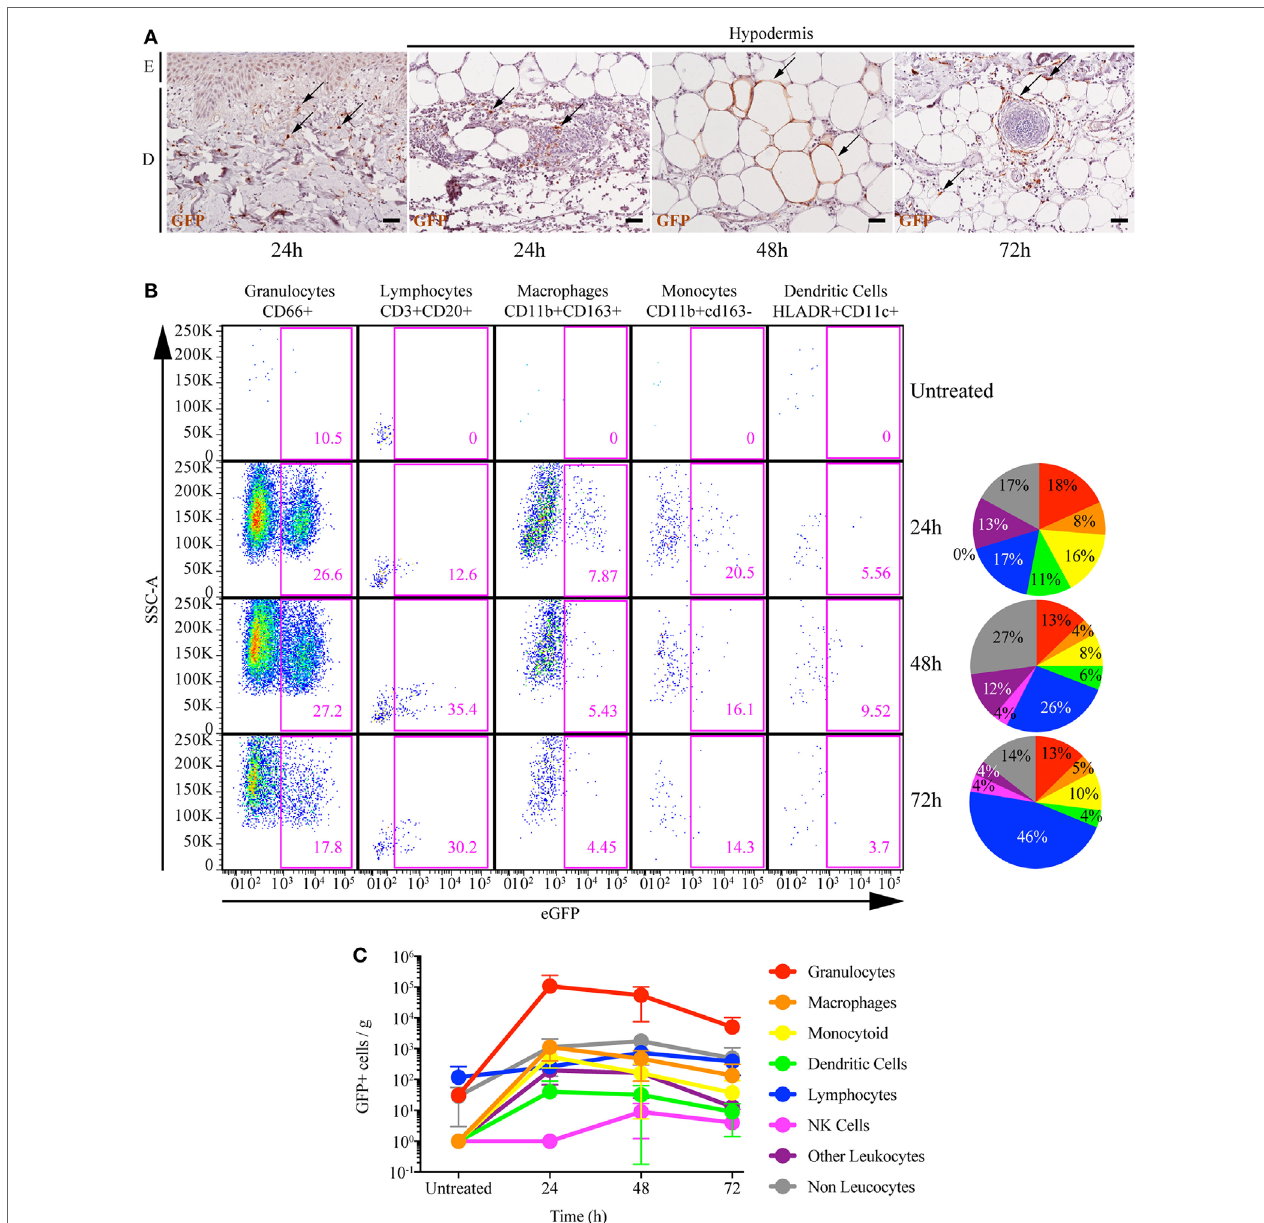
FigUre 2 | rMVA infects a wide range of skin cell types. (a) In situ localization of cells infected with rMVA. Transversal sections of paraffin-embedded skin biopsies were stained with an anti-GFP antibody and then colored with HE. E and D indicate the epidermis and the dermis, respectively. Scale bars correspond to 100 µm. Arrows indicate GFP + cells as example. (B) Percentage of rMVA-infected cells in the skin. The dot plots show the evolution of recruitment of the main immune cells to the skin and the percentage of GFP + cells. (c) Number of GFP + cells per gram of skin biopsy. The numbers of GFP + cells in the indicated cell population were normalized to the weight of the skin biopsies. The graph represents the mean ± SD ( n = 3). See also Figure S3 in Supplementary Material for gating